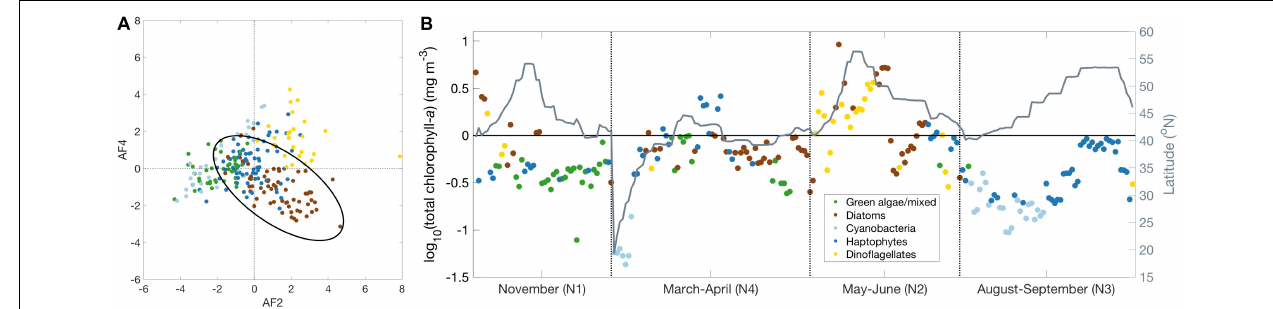
FIGURE 7 | (A) Amplitude function of Mode 4 vs. Mode 2. When Mode 2 and Mode 4 are both positive, dinoflagellates can be separated from diatoms. Using this metric, samples are colored by the dominant community detected in the community detection analysis (light blue = cyanobacteria, dark blue = haptophytes, green = green algae/mixed, brown = diatoms, gold = dinoflagellates). The black ellipse encircles 95% of the diatom samples. (B) Resulting spatiotemporal distribution of all five communities identified using network-based community detection and EOF regression (latitude plotted in gray). TABLE 2 | Summary of environmental and ecological variables for surface samples on NAAMES 1-4, divided into results of network-based community detection analysis. Parameter Green algae Diatom Cyanobacteria Haptophyte Dinoflagellate community community community community